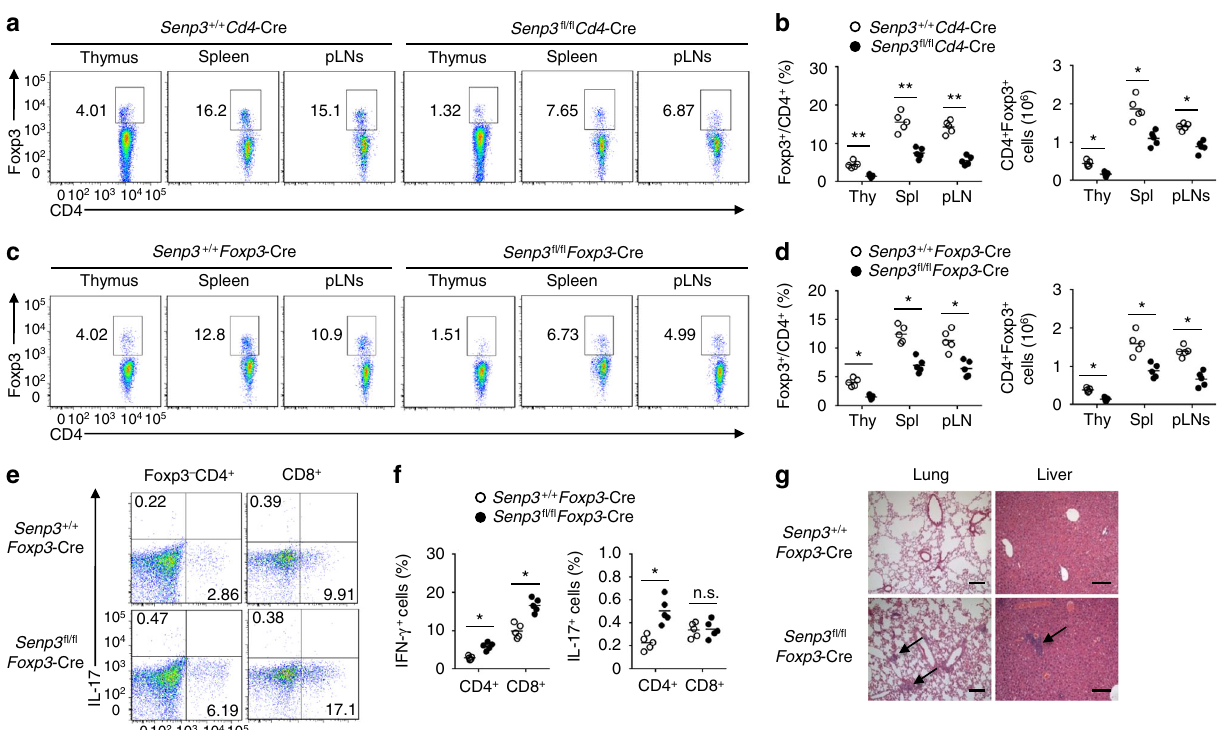
Fig. 2 SENP3 ablation in Treg cells results in dysregulated immune tolerance. a , b Flow cytometric analysis of Treg cell percentage and number from the thymus (Thy), spleen (Spl), and peripheral lymph nodes (pLN) of 6-week-old Senp3 + / + Cd4 -Cre and Senp3 fl / fl Cd4 -Cre mice. c , d Flow cytometric analysis of Treg cell percentage and number from the thymus (Thy), spleen (Spl), and peripheral lymph nodes (pLN) of 6-week-old Senp3 + / + Foxp3 -Cre and Senp3 fl / fl Foxp3 -Cre mice. e , f Flow cytometric analysis of the percentage of IFN- γ -producing and IL-17-producing CD4 + and CD8 + T cells in the spleen of 8-week- old Senp3 + / + Foxp3 -Cre and Senp3 fl / fl Foxp3 -Cre mice. g Hematoxylin-eosin staining of the indicated tissue sections from 8-month-old Senp3 + / + Foxp3 -Cre and Senp3 fl / fl Foxp3 -Cre mice, showing immune cell in fi ltrations into the tissues of Senp3 fl / fl Foxp3 -Cre mice (arrows). Bars, 100 μ m. Data are representative of three or more independent experiments. Error bars are the mean ± SEM values. n = 5. Two-tailed unpaired Student ’ s t tests were performed. n.s. not statistically signi fi cant; * P < 0.05; ** P <